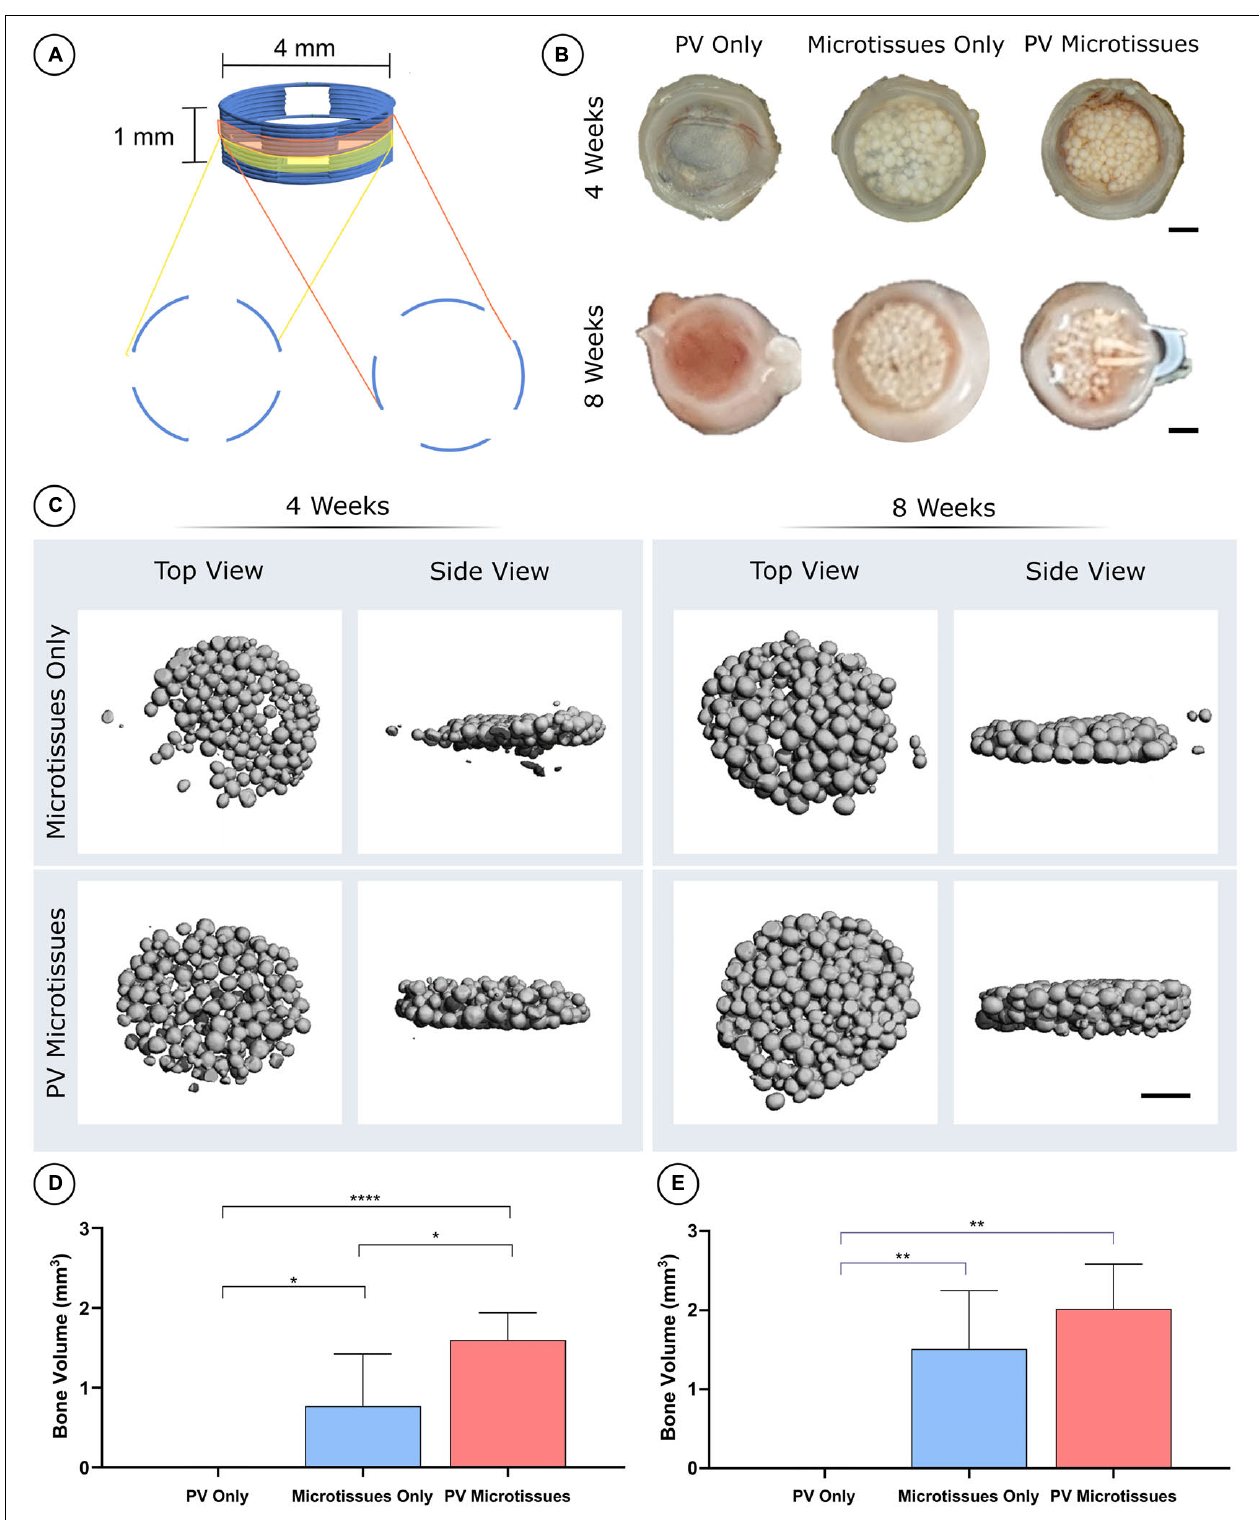
FIGURE 4 | MicroCT analysis of constructs post-implantation. (A) Schematic of 3D printed PCL scaffolds. (B) Macro images of all three groups at 4 and 8 weeks. Scale bar = 1 mm for all images. (C) 3D reconstructions of microCT scans of the microtissues only and PV microtissues groups at 4 and 8 weeks post-implantation. Quantification of bone volume (mm 3 ) at (D) 4 weeks and (E) 8 weeks significant differences are denoted as; *where p < 0.05, **where p < 0.01, and ****where p < 0.0001 when tested using a one-way ANOVA followed by Tukey post hoc test (mean ± SD, n = 6 for PV microtissues and n = 4 for microtissue only and PV only) (D)